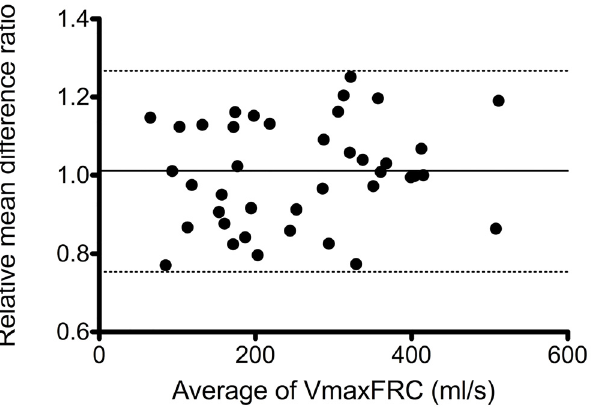
Fig 3. Short-term repeatability of VmaxFRC. Bland-Altman plot of the agreement in VmaxFRC is analyzed between two measurements sets 15 min apart. Data are plotted as the difference between two measurements versus the mean of the two measurements. Differences for individuals are shown as solid circles. The mean of the differences and the upper and lower limits of agreement are plotted as solid and dash lines